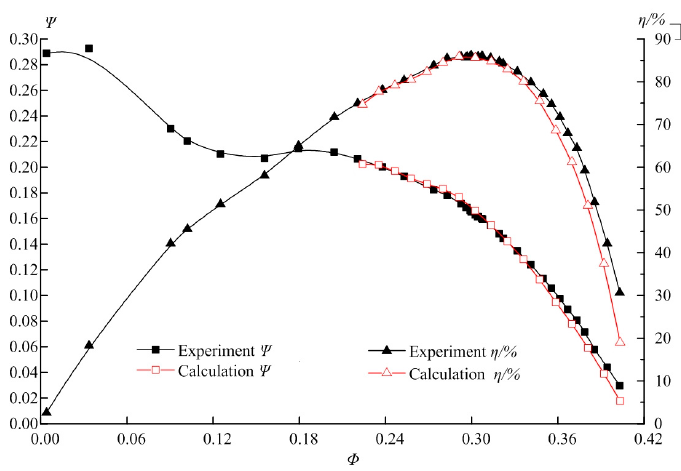
Figure 5. Comparison of pump performance between experiment and calculation results.